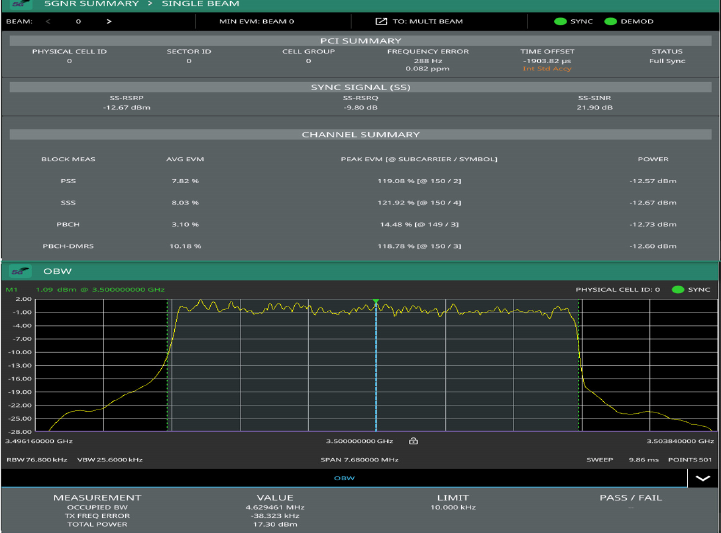
Figure 4. Transmitted signal demodulation, occupied bandwidth, channel power, and spectrum from the implemented